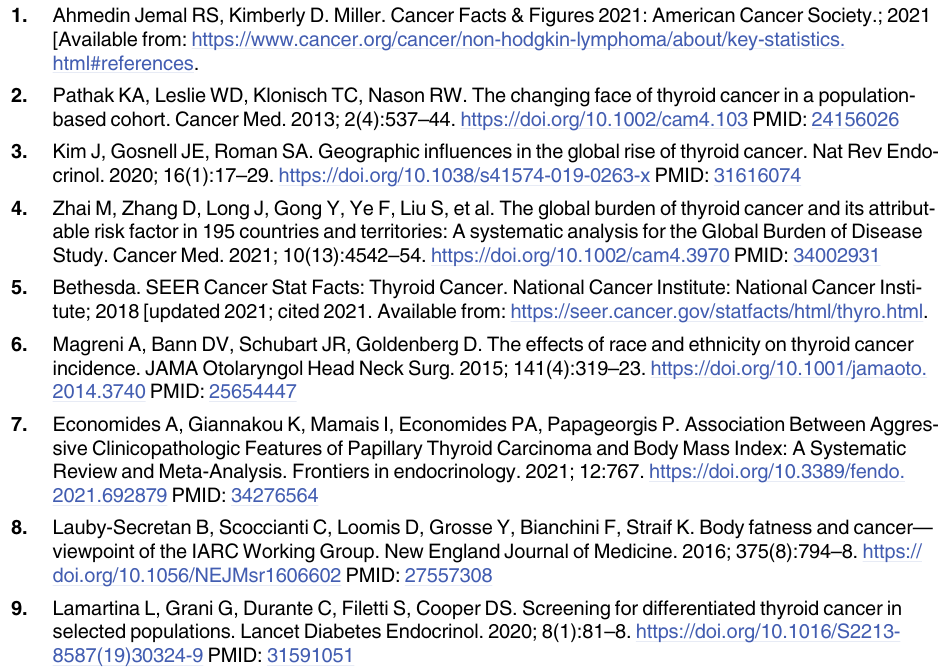
S1 Table. Detailed of the risk of bias in non-randomized studies of interventions (ROBINS-I) for each included cohort study. S2 Table. Detailed of the risk of bias in non-randomized studies of interventions (ROBINS-I) for each included